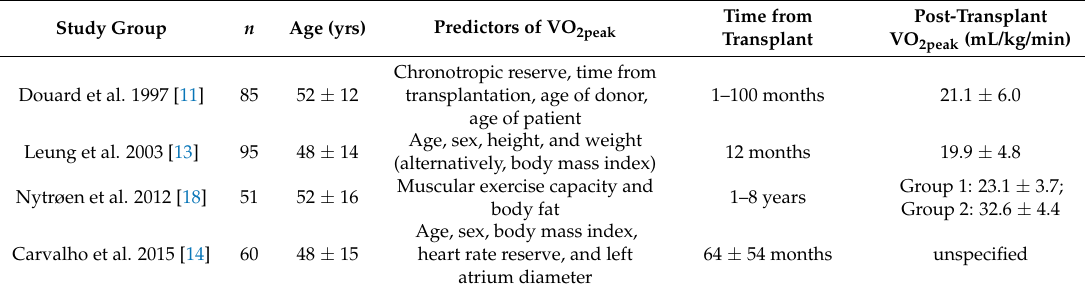
Table 5. Predictors of VO 2peak in heart transplant